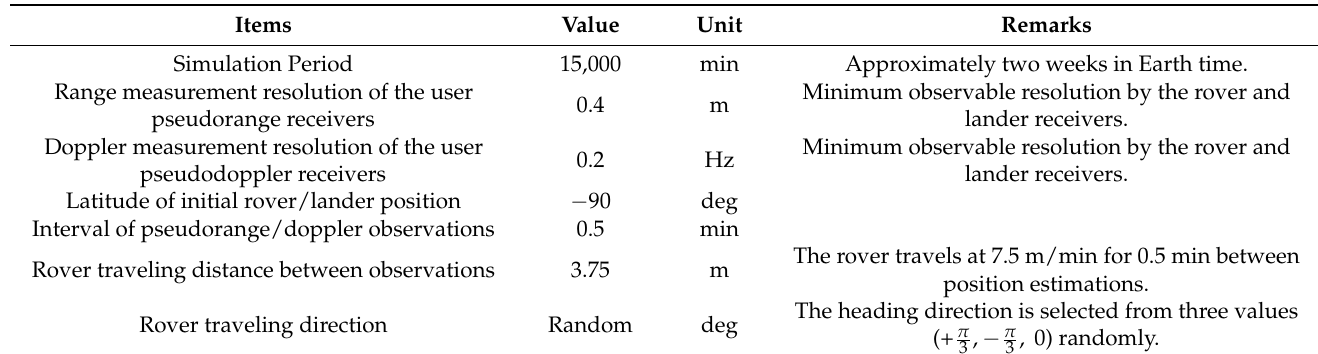
Table 5. The simulation